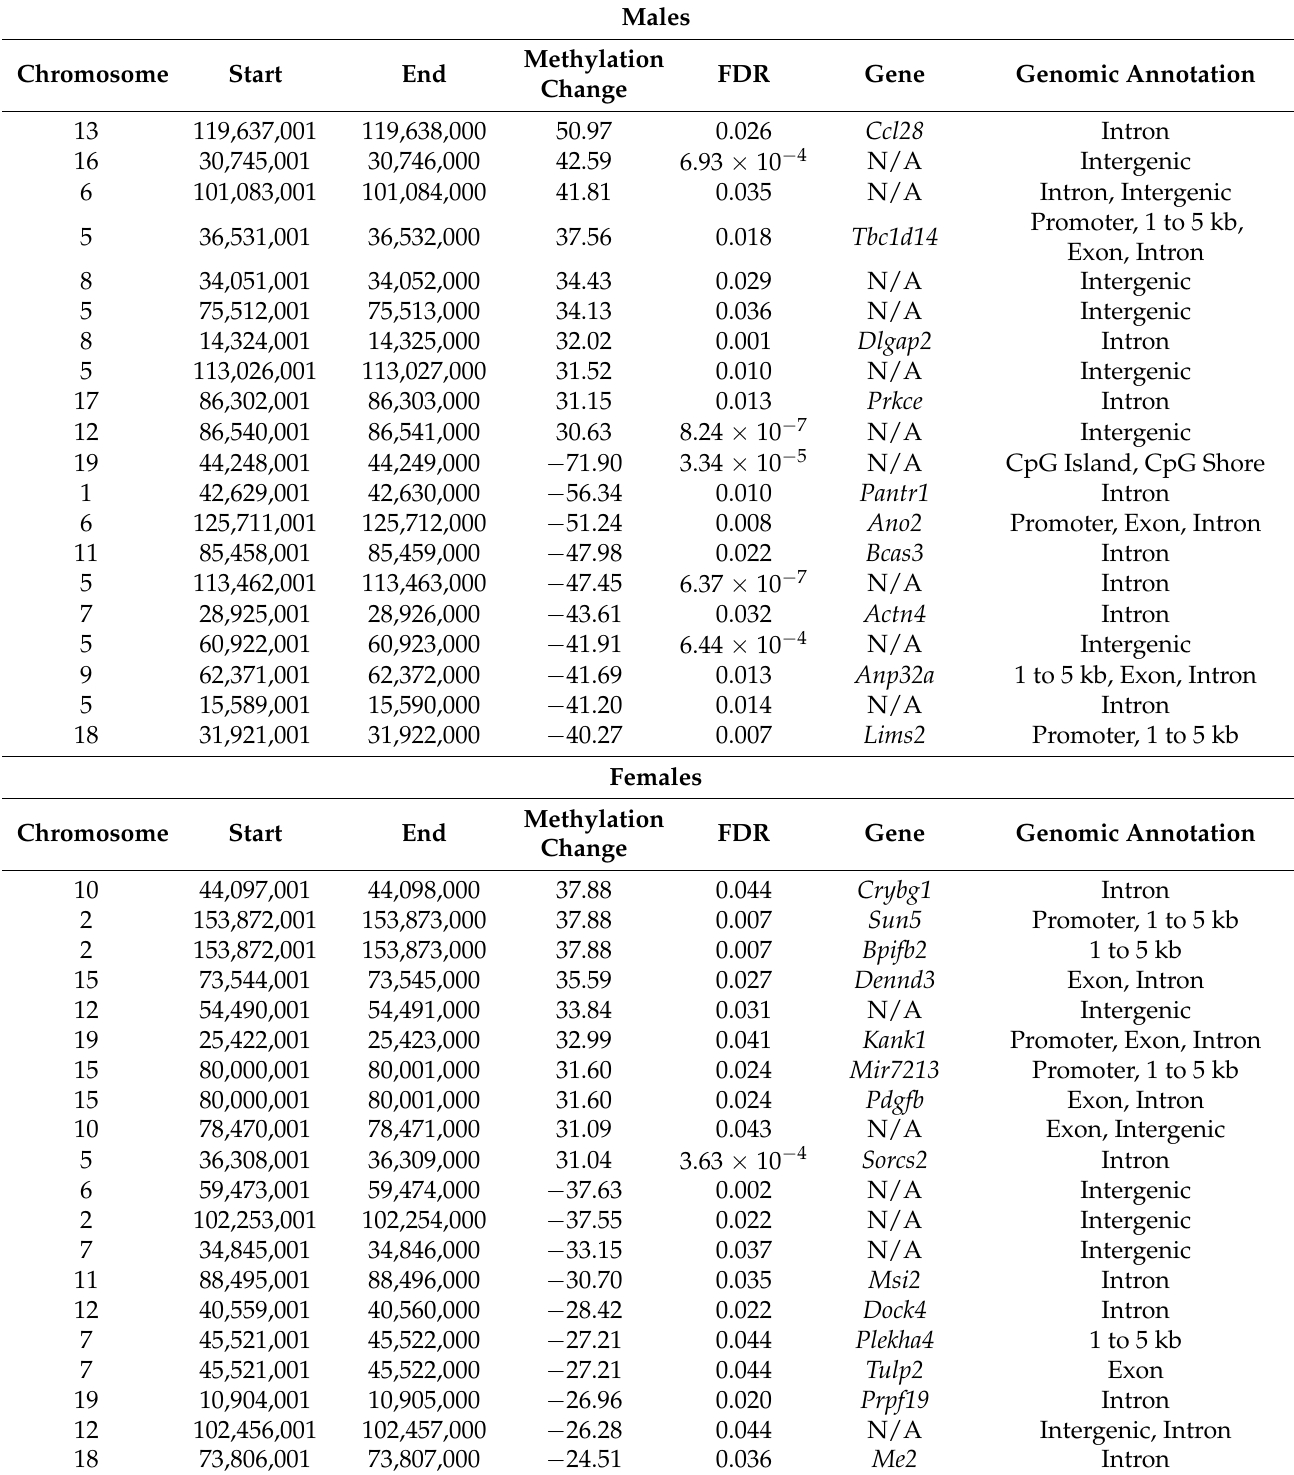
Table 4. Top 10 differentially hypo- and hyper-methylated regions (DMRs) in each sex, ranked by methylation change.